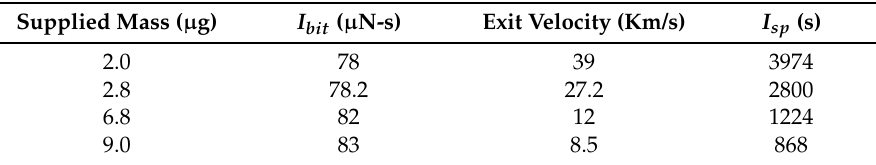
Table 5. Comparison of different supplied ablation